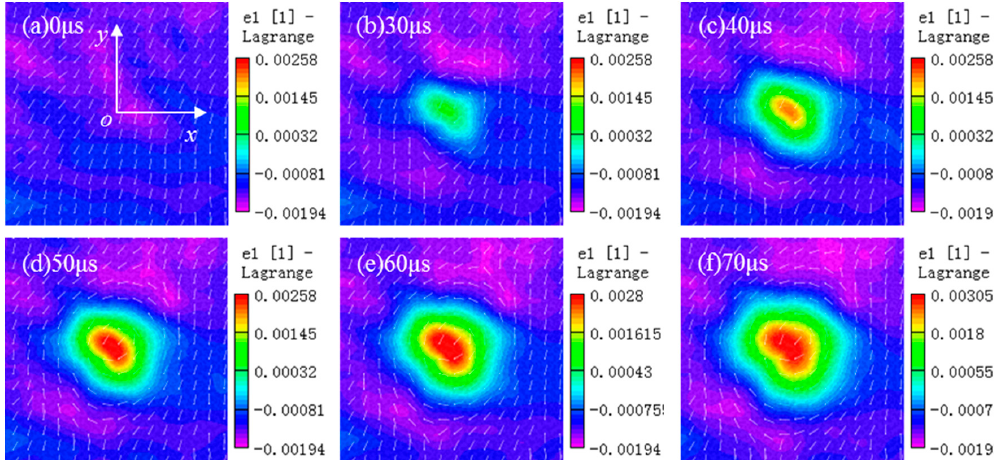
Figure 9. Magnitude and direction of maximum principal strain on the free surface in case of equal biaxial compression: ( a – f ) images of maximum principal strain after 0 μ s, 30 μ s, 40 μ s, 50 μ s, 60 μ s and 70 μ s of explosion.